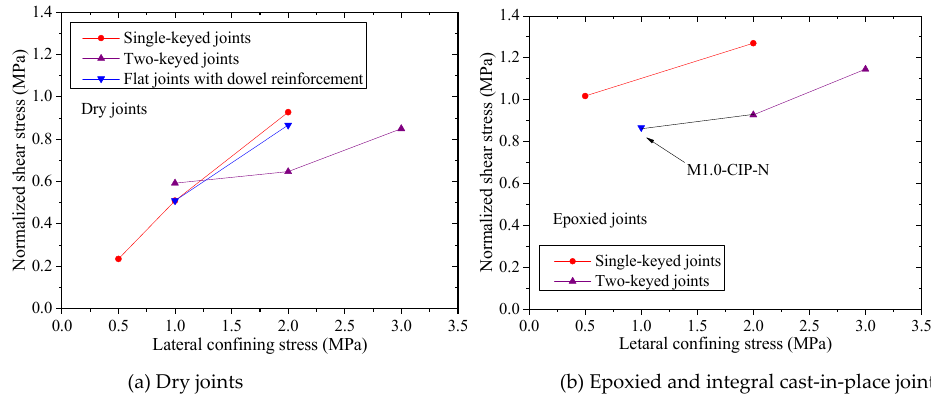
Figure 10. Normalized average shear stress-lateral confining stress relationships of the joints of the same type under different confining stresses: ( a ) dry joints; ( b ) epoxied and integral cast-in-place